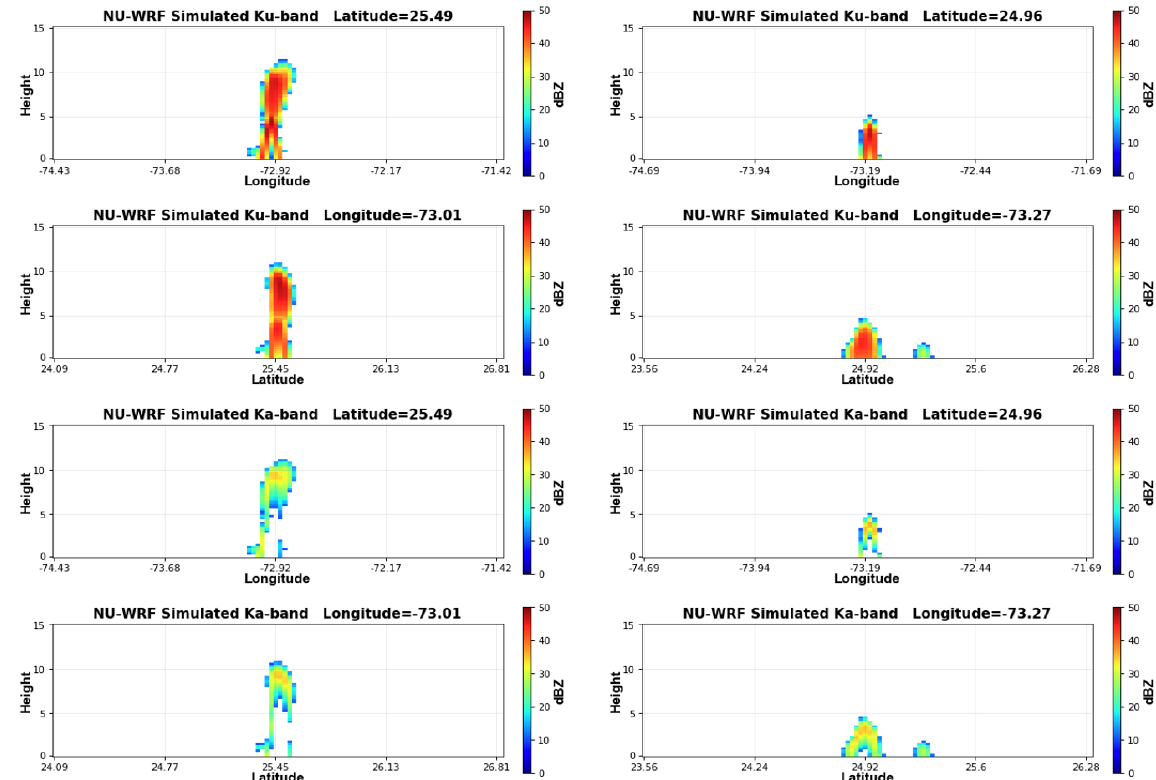
Figure 11. Convection in the 21:00UTC analysis. (Left column) NU-WRF simulated DPR profiles under the black dashed lines crossing at 25.5 ◦ N, 73 ◦ W in the box in Fig. 10. From top to bottom: vertical profile of Ku-band reflectivity under the E–W line (latitude 25.5 ◦ N), Ku band under the N–S line (longitude 73 ◦ W), and these same two again but for the Ka-band simulation. The right column is the same as the left, but for the NU-WRF simulated DPR profiles under the black dashed lines crossing at 25 ◦ N, 73.3 ◦ W in the box in Fig. 10.